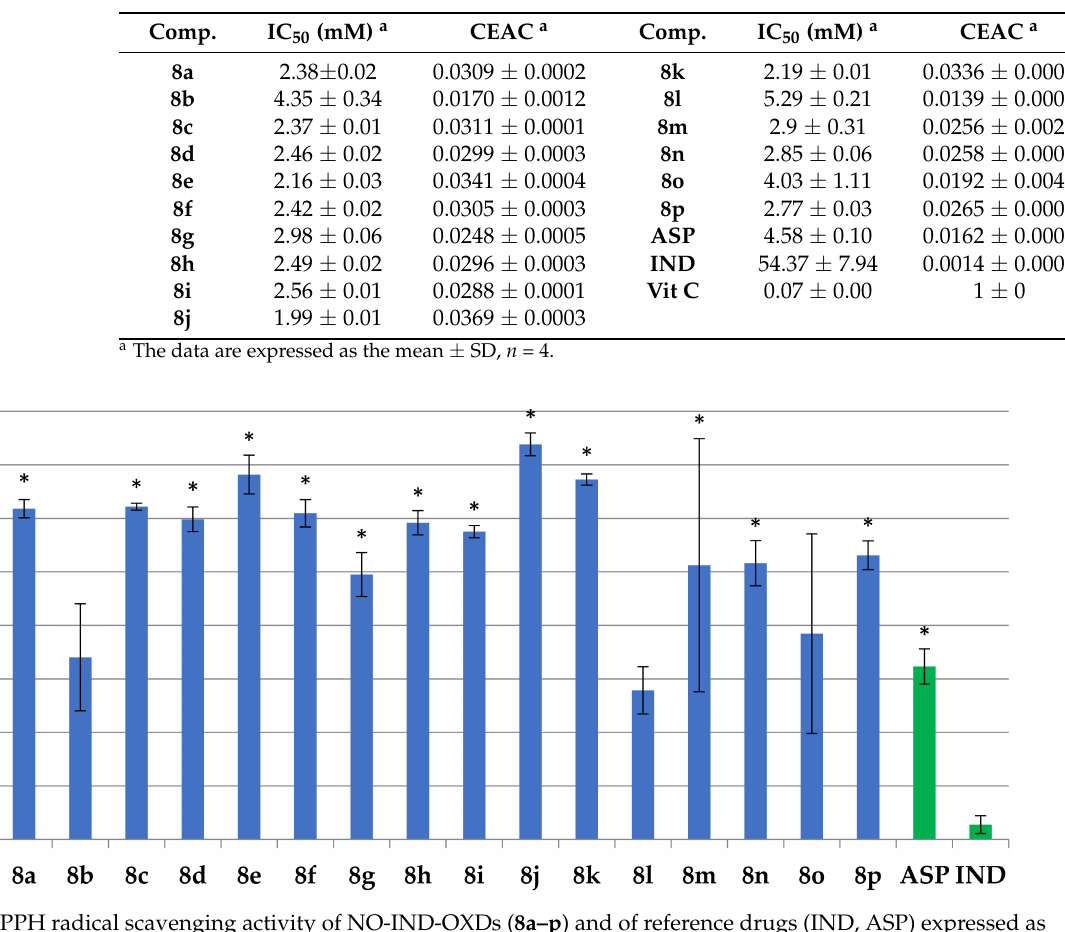
Table 2. The IC 50 and CEAC values of NO-IND-OXDs 8a–p referring to the DPPH radical scaveng- ing effect.